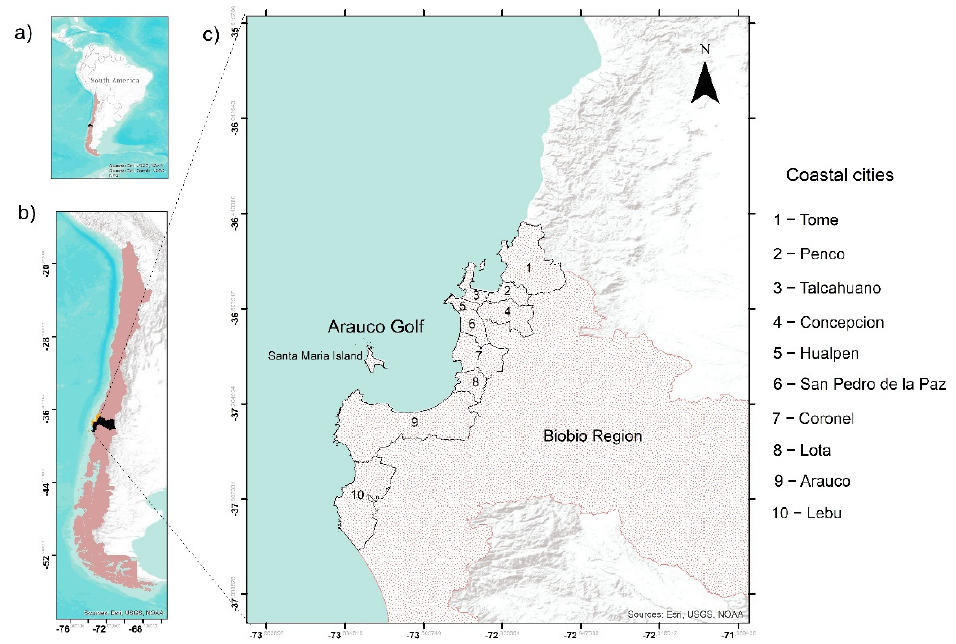
Figure 1. ( a ) Chile located in South America, ( b ) Biobio region, and ( c ) zoom of the study area and their municipalities. Source: Adapted from Spatial Data Infrastructure Chile (https://www.ide.cl/, accessed on 26 December 2021).